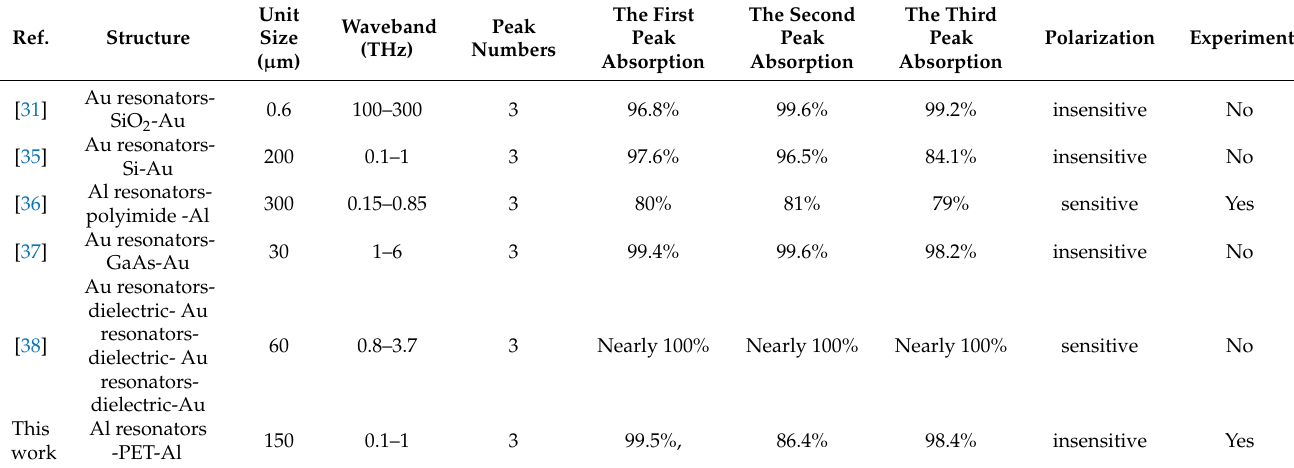
Table 1. Comparison results of various three-band